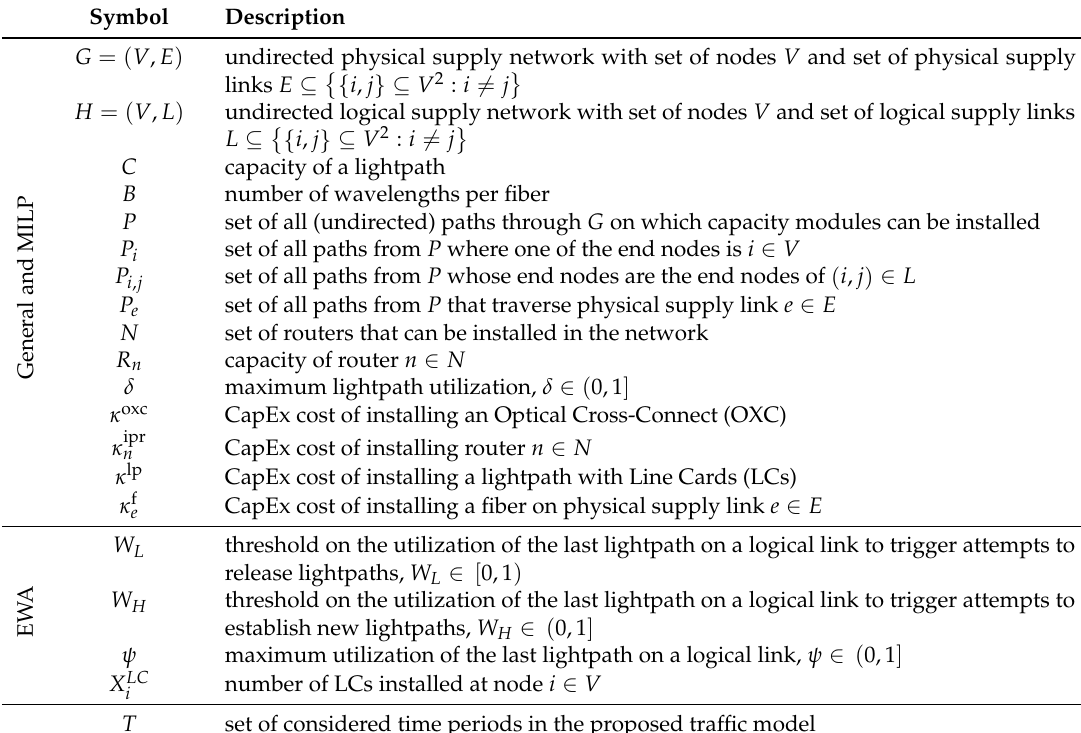
Table A2. Notation of parameters used for traffic model, network design (MILP), network operation (EWA), and